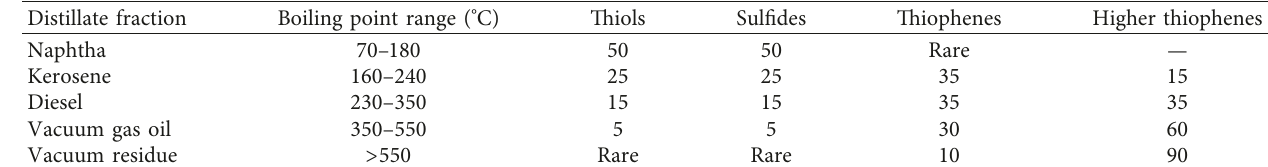
Table 1: Distribution of sulfur compounds in different petroleum distillates (wt.%).